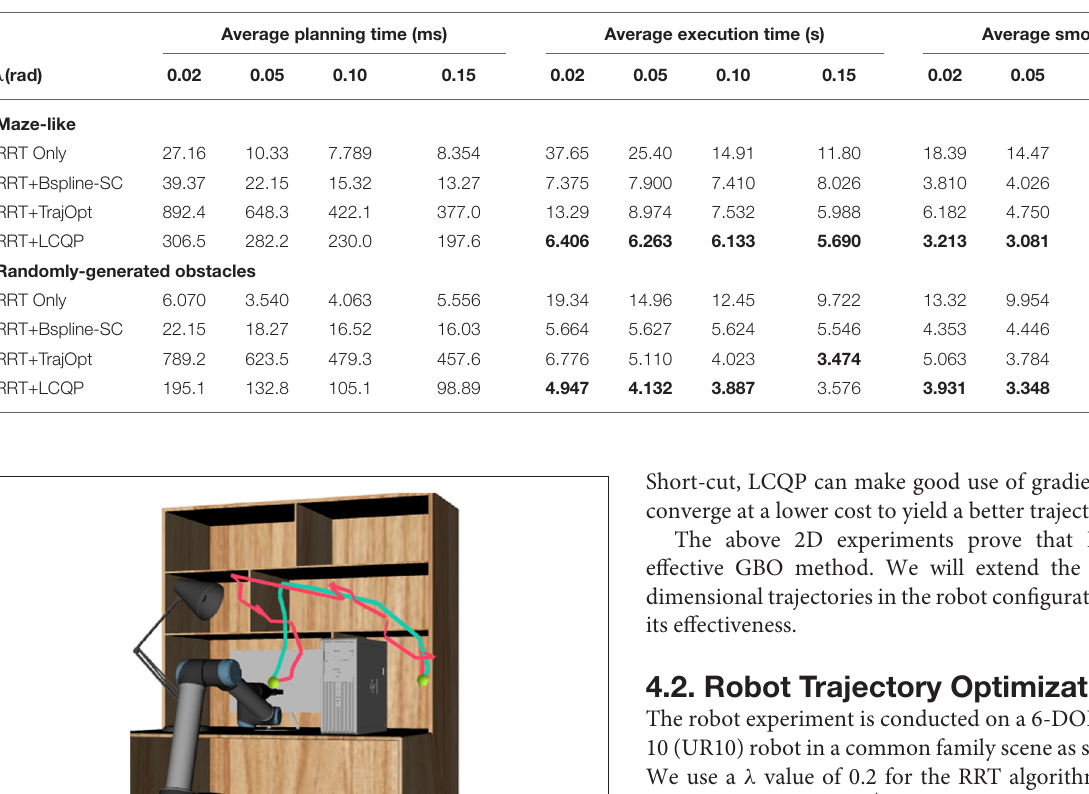
TABLE 2 | Results of the 2D-experiments.